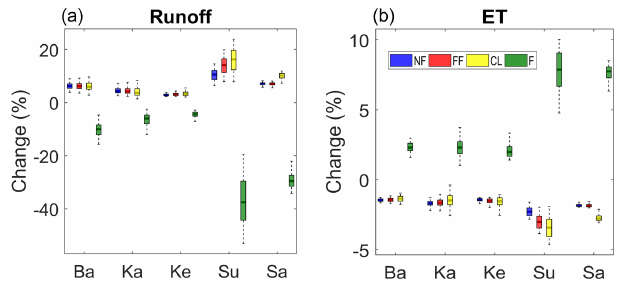
Figure 8. Percent change in (a) mean runoff (b) mean ET aver- aged annually over the time (2001–2010) in the Near Future (NF), Far Future (FF), Cropland (CL) and Forest (F) scenarios with re- spect to baseline scenario for all the subcatchments. Note that the daily meteorological forcing used in all the model simulations is ob- tained from the current climatology (i.e., 1990–2010). The results are shown for the behavioural model simulations obtained through